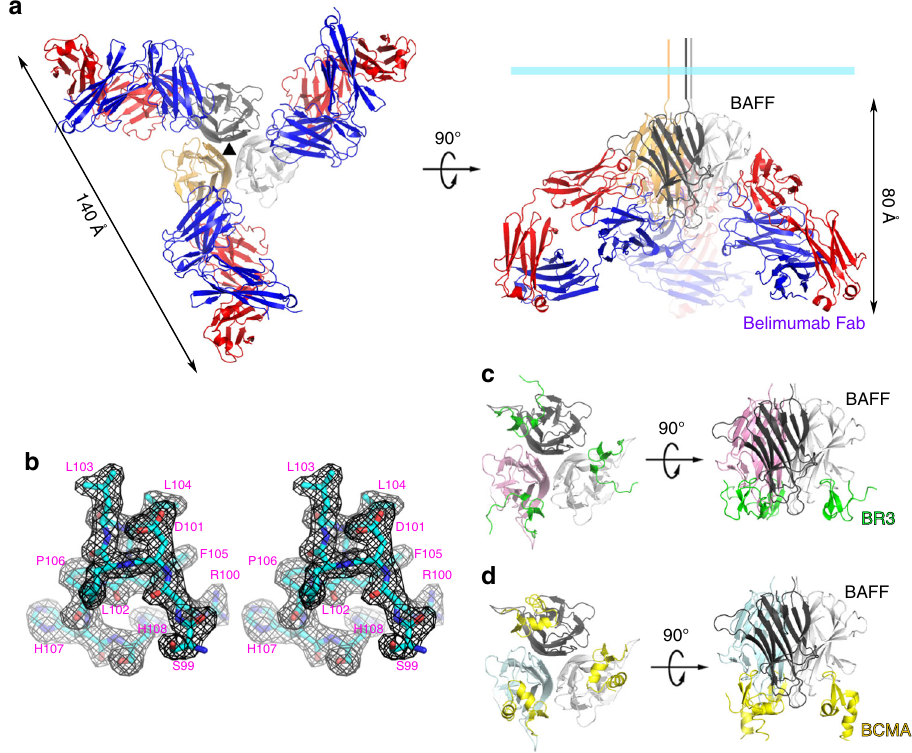
Fig. 1 Overall structure of BAFF in complex with belimumab Fab. a Ribbon representation of the BAFF trimer (yellow, black, gray) in complex with the belimumab Fab fragment (heavy chain: blue; light chain: red) in two orientations. The 3-fold axis of the trimeric complex is indicated as a black triangle. The cyan bar indicates the putative membrane of a BAFF-producing cell if the BAFF trimer is in its membrane-bound form. b Stereoview of the 2 f o – f c composite omit map (1.2 σ contour level) at HCDR3 of belimumab in the complex structure, calculated at 2.05 Å resolution. c Structure of the BAFF trimer (pink, black, gray) in complex with three BR3 (green) proteins (PDB ID code 1OQE). d Structure of BAFF trimer (cyan, black, gray) in complex with three BCMA